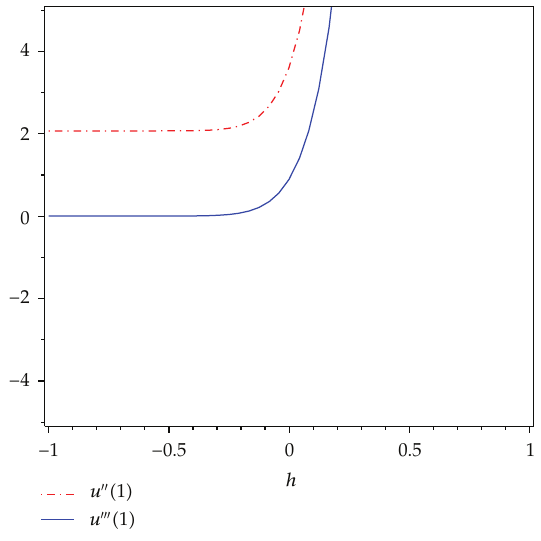
Figure 2: 4th-order SHAM h